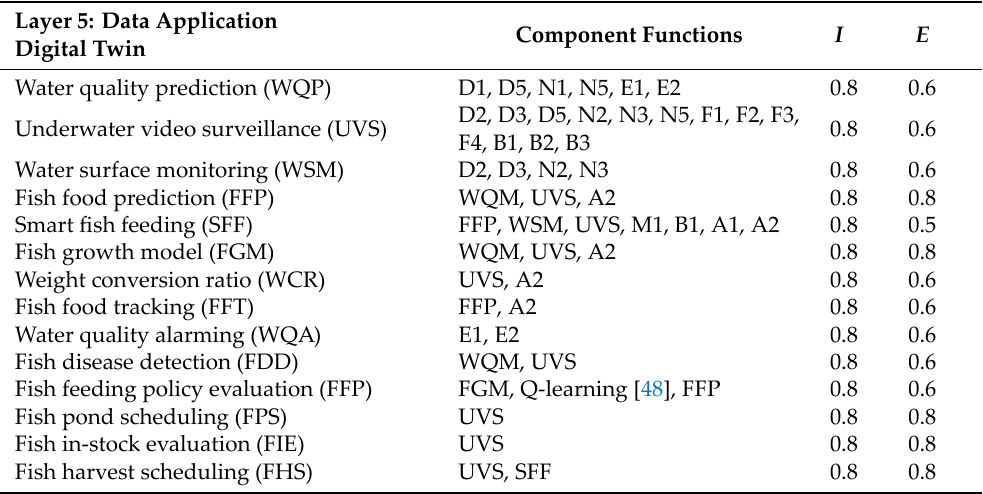
Table 4. Layer 5 of the Digital Twins as a provider of fish farm data applications based on the asso‑ ciated user